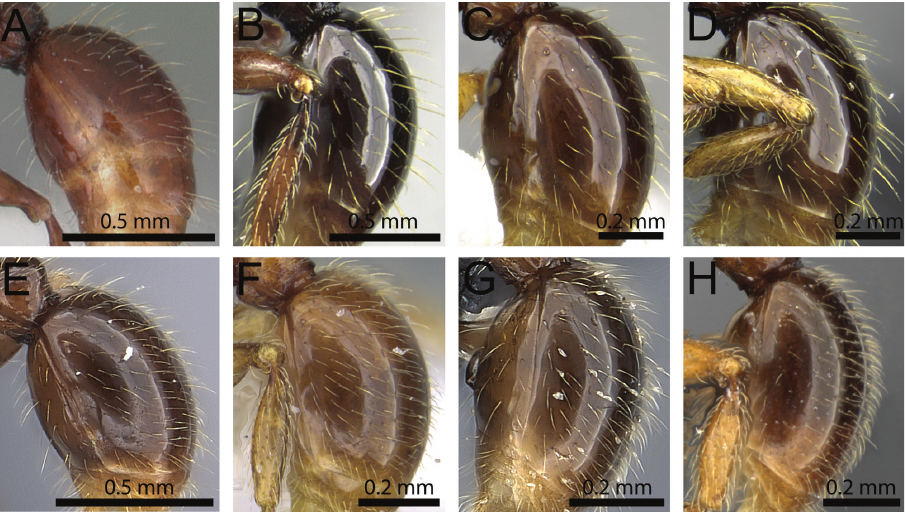
Figure 28. First gastral tergite in profile. A T. dysalum (CASENT0102349) B T. yammer (CASENT0042832) C T. vohitra (CASENT0189167) D T. sargina (CASENT0487390) E T. alperti (CASENT0042547) F T. gilgamesh (CASENT0247312) G T. gilgamesh (CASENT0163251) H T. en- kidu